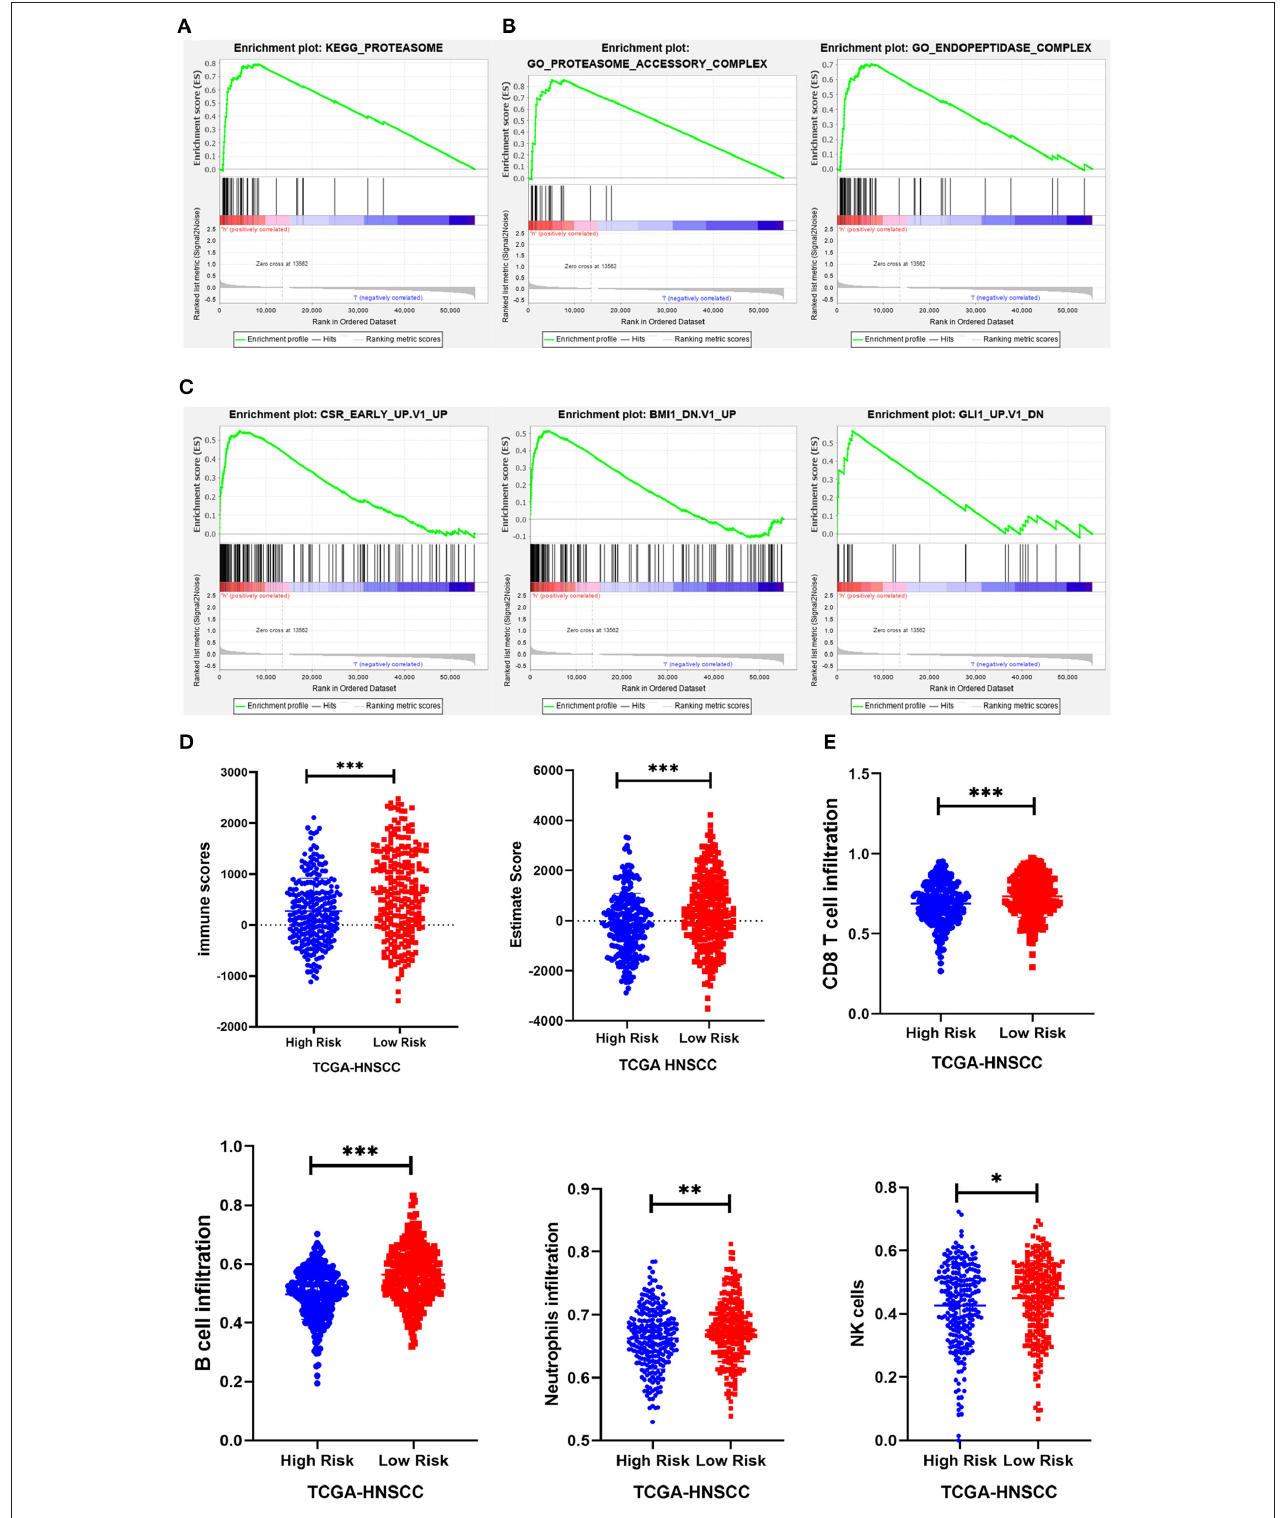
FIGURE 8 | GSEA and immunity correlation analysis of seven prognostic genes. (A–C) The results showed that 1 KEGG pathway, 2 GO terms, and 3 oncological signatures were enriched in the high-risk group. (D) The immune score and estimated score of the high-risk group were significantly lower in the TCGA cohort. (E) The infiltration level of immune cells (including CD8 + T cells, B cells, neutrophils, and NK cells) in the low-risk group was significantly higher than that in the high-risk group in the TCGA cohort. * P < 0.05, ** P < 0.01, and *** P < 0.001 respectively.